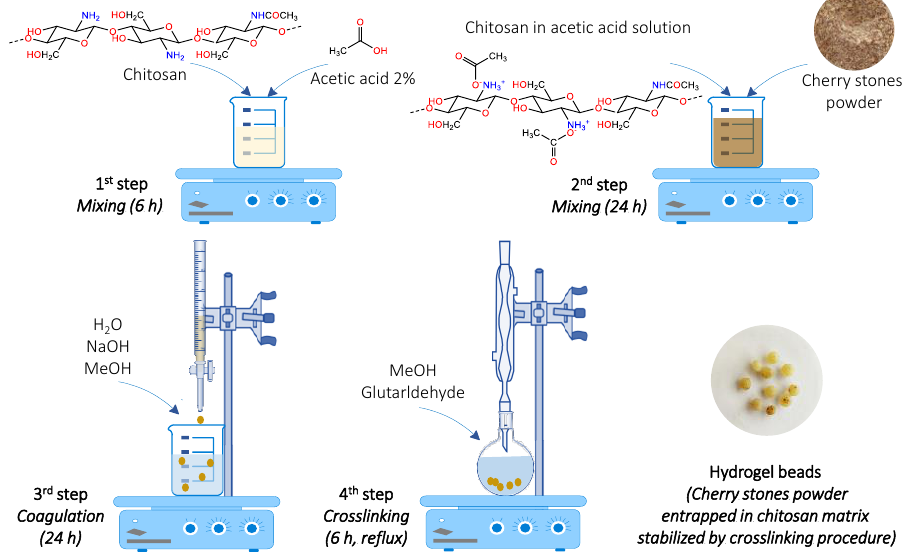
Figure 1. Hydrogel beads preparation procedure. As shown in Figure 2A, the resulted beads (abbreviated CSCH) have a uniform spherical shape and a white, light yellow color with visible grains of cherry stones powder. Their mean diameter was 2.5 mm ± 0.2